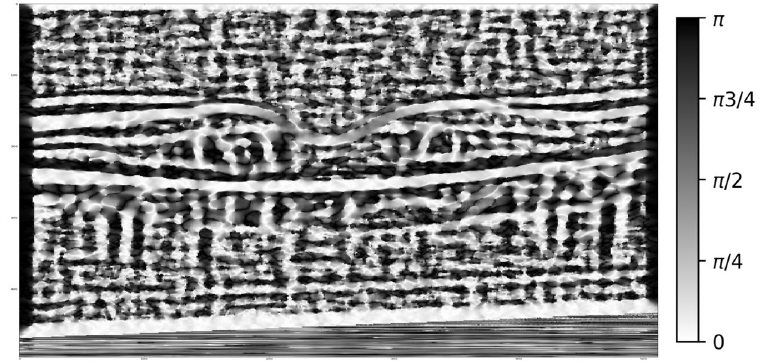
Figure 3. Local image orientation computed using masked local image